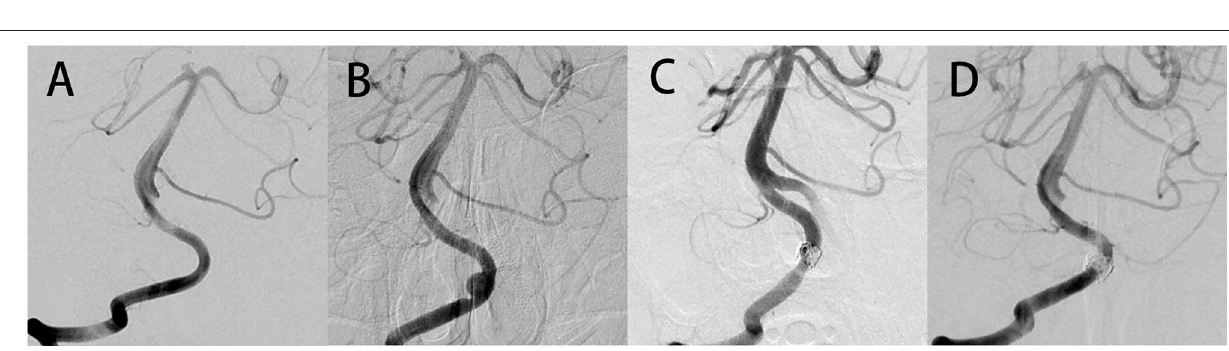
FIGURE 1 | MR image detected a partially thrombosed aneurysm adjacent to the left part of medulla (A) . 3D DSA image demonstrated a VADA in the fourth segment of the left VA (B) . Angiography at 5 months follow-up revealed that the stent were patent with partial aneurysm residues (C) . Partial residual aneurysm of the left VADA was observed on 14 months (D) and 2 years (F) follow-up angiography, and complete occlusion on 3 years (G). The volume of the aneurysm was not significantly changed from 14 months (E) and 2 years follow-up MR images (H) .